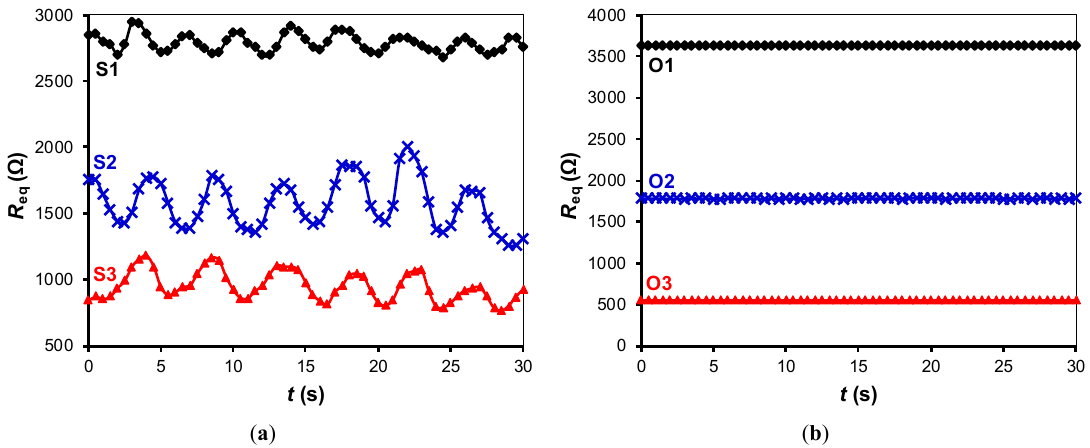
Figure 10. Experimental resistance variations monitored by the DIC in Figure 3 when over the chair we had: ( a ) subjects of different weight and age in the sitting posture P2; ( b ) objects of different weight. The test was carried out at f s = 2 Sa/s with C = 470 nF.